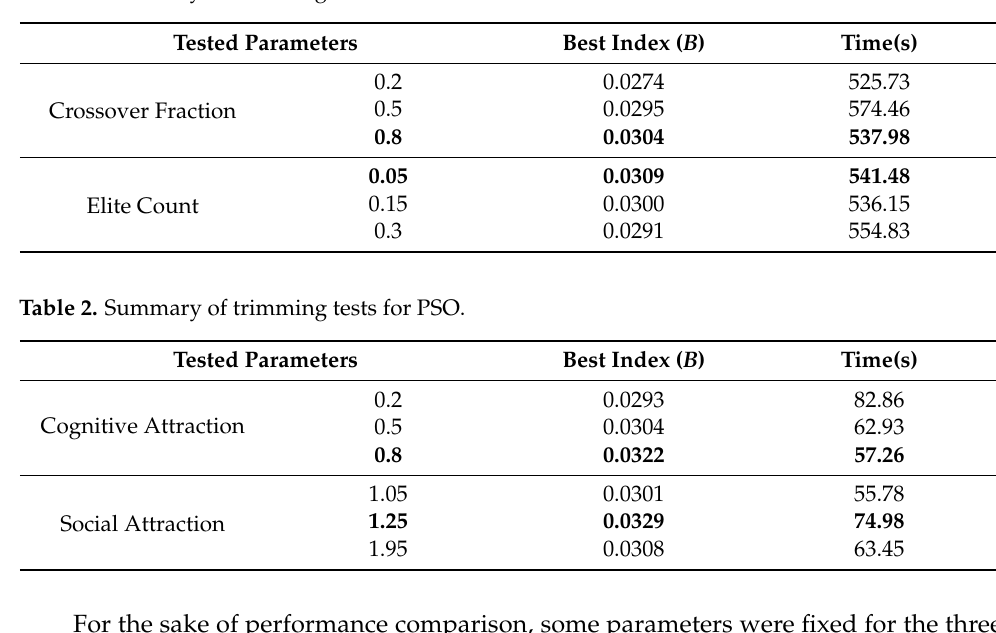
Table 1. Summary of trimming tests for the GA.